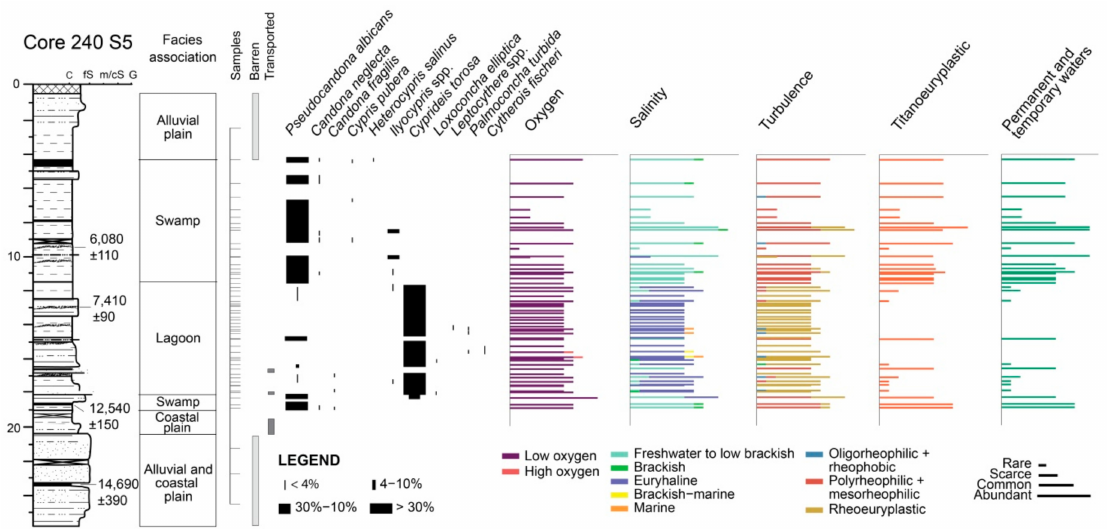
Figure 6. Vertical distribution patterns of benthic ostracods in core 240 S5. Relative abundances of taxa and ecological groups, reported as abundance categories are shown. Samples with no or transported ostracod valves are